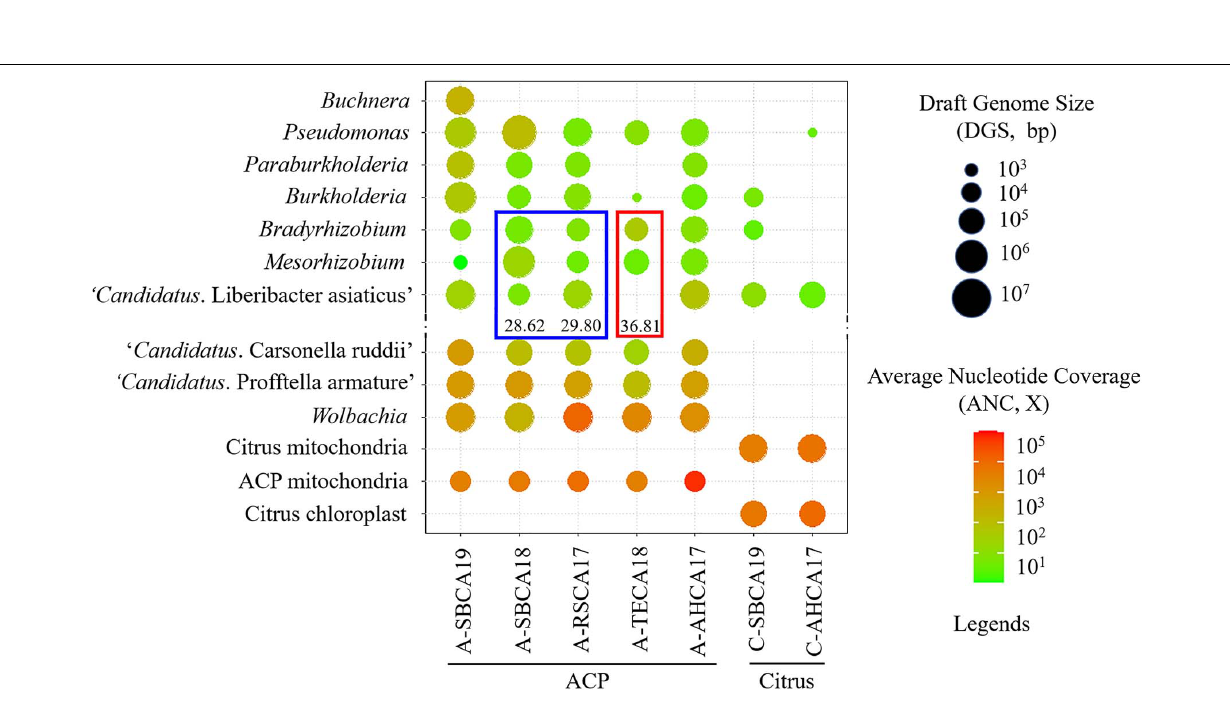
Frontiers in Microbiology |